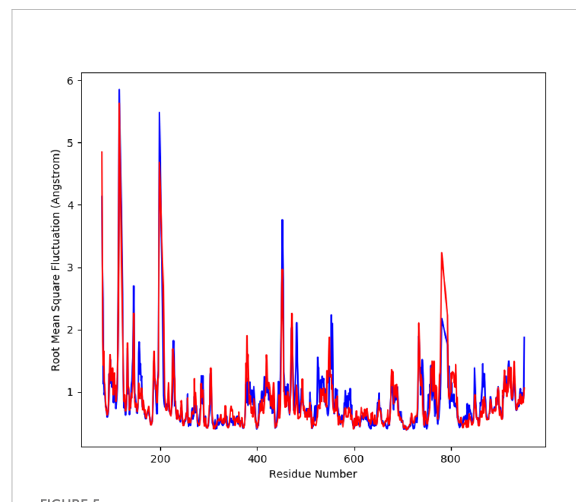
FIGURE 6 Rg plot representing changes observed in the conformational behavior of protein-ligand complexes (red depicting protein- ligand complex, while blue indicating protein) for 100 ns MD